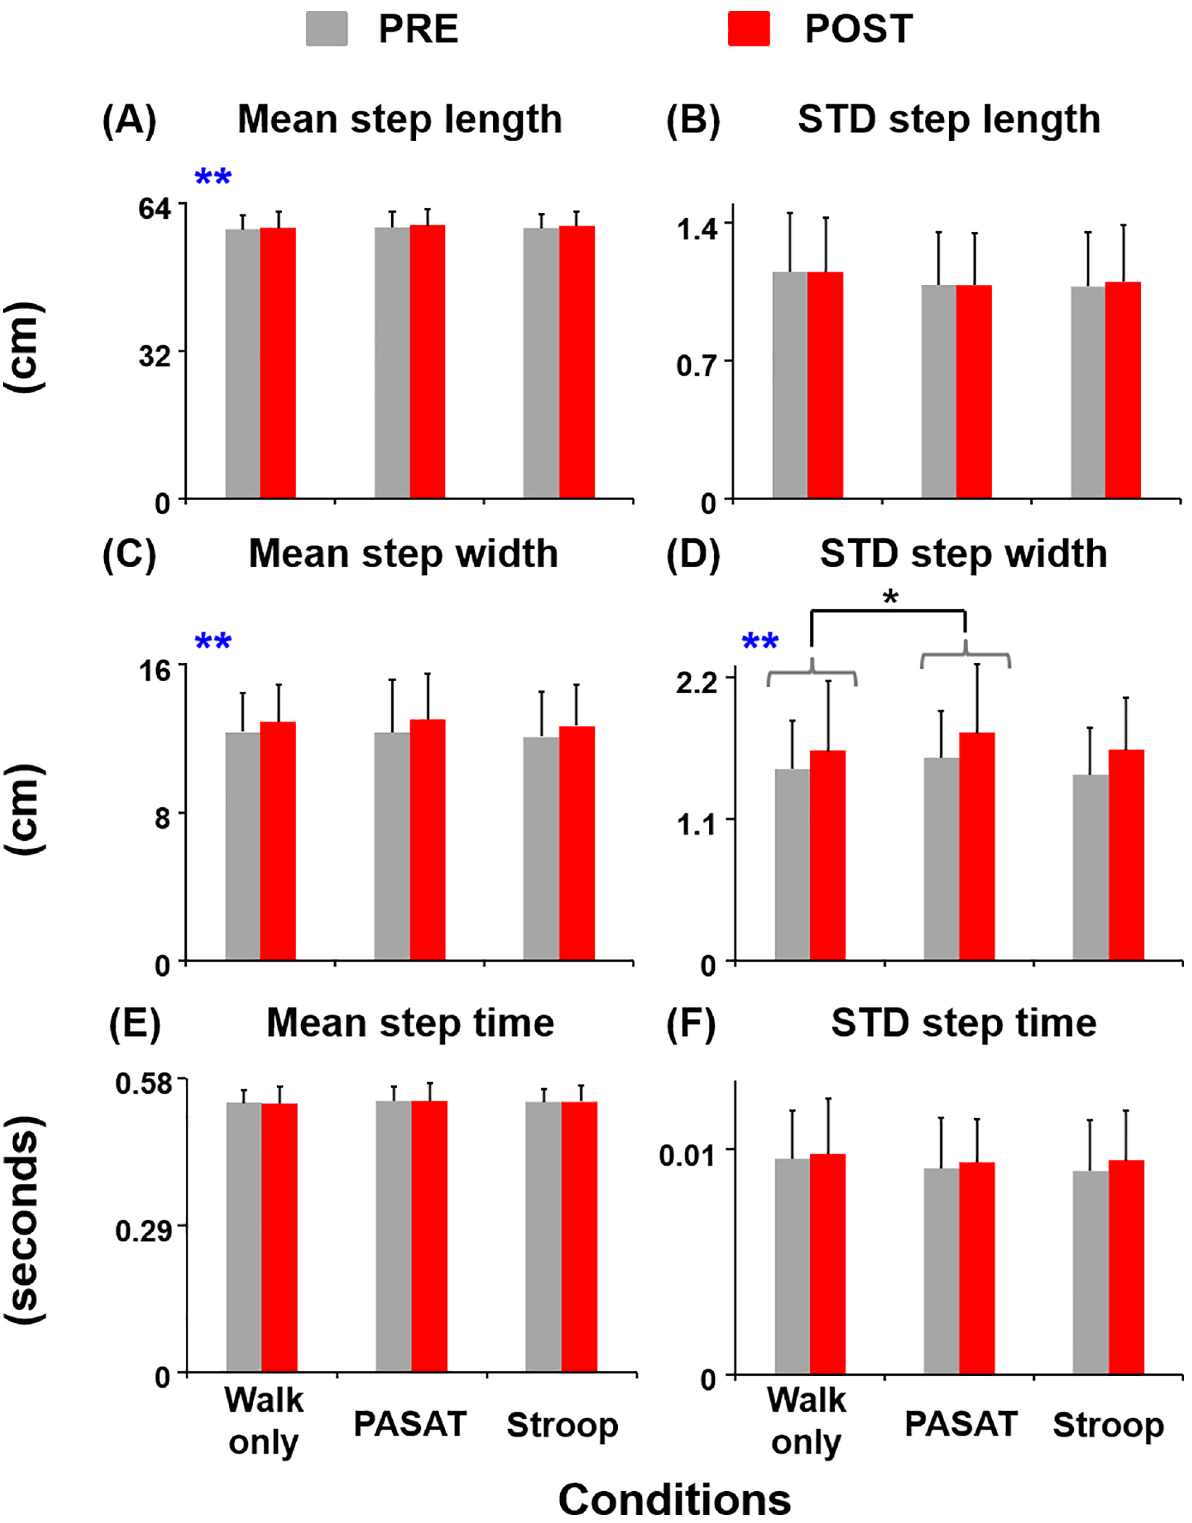
Fig 3. Step measures. (A) Mean and (B) variability of step length, (C) mean and (D) variability of step width, and (E) mean and (F) variability of step time before (PRE, grey bars) and after (POST, red bars) the exercise session. Error bars represent 1 STD. (cid:3)(cid:3) indicates significant difference between the PRE and POST. (cid:3) indicates significant difference from the walking only condition (THSD, p < 0.05).